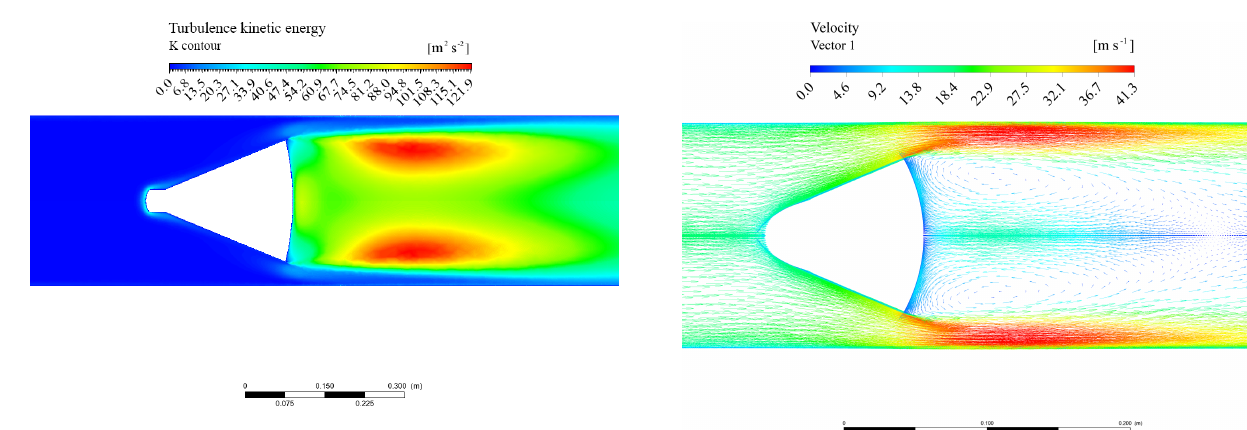
Figure 15. K contour plot, S-G V-Cone.